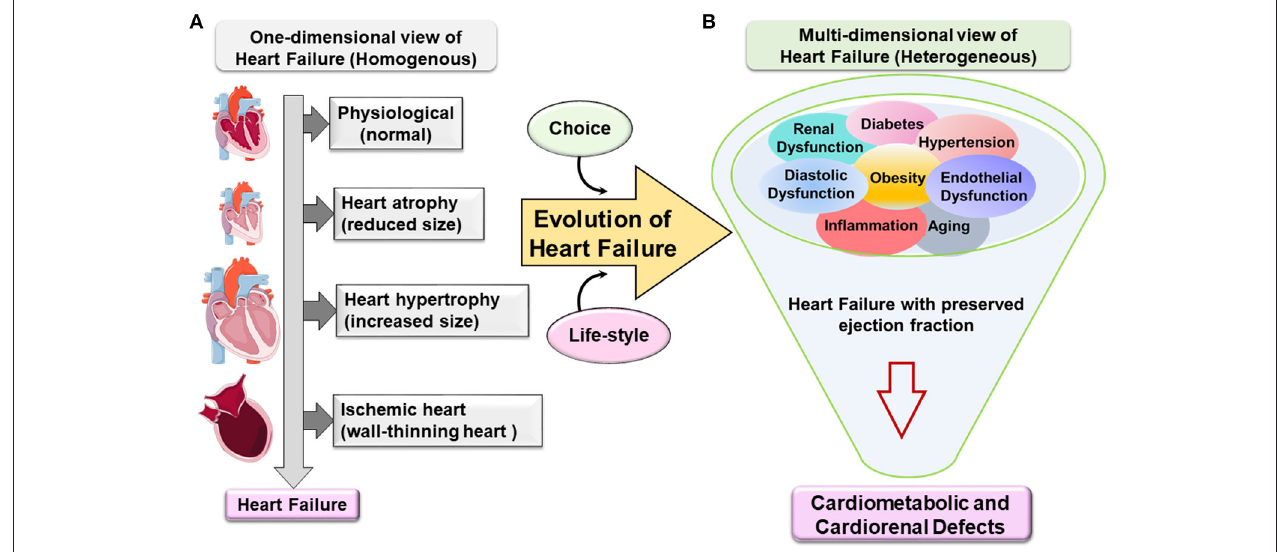
FIGURE 1 | Evolution of one-dimensional to multidimensional view of cardiovascular disease and heart failure. (A) One-dimensional view of heart failure (HF). Classically, HF emerges in a homogenous population based on geometry, structure, and function. The progress from being a phenotypically normal to abnormal structure accompanied with a decrease or increase in the (cardiomyocyte) heart size due to eccentric or concentric remodeling or following ischemic injury with dilation of the chambers and wall-thinning effect. HF specifically with preserved ejection fraction evolves from one-dimensional view to multidimensional view. (B) Metabolic defects directed the multidimensional view of heart failure with preserved ejection fraction (HFpEF). Heterogeneous metabolic comorbidities are a primary confounder in HFpEF patients like obesity, hypertension, kidney dysfunction, diabetes, aging, etc. The complexity of the HFpEF syndrome resulted in cardiometabolic and cardiorenal defects with signs of suboptimal inflammation without any current